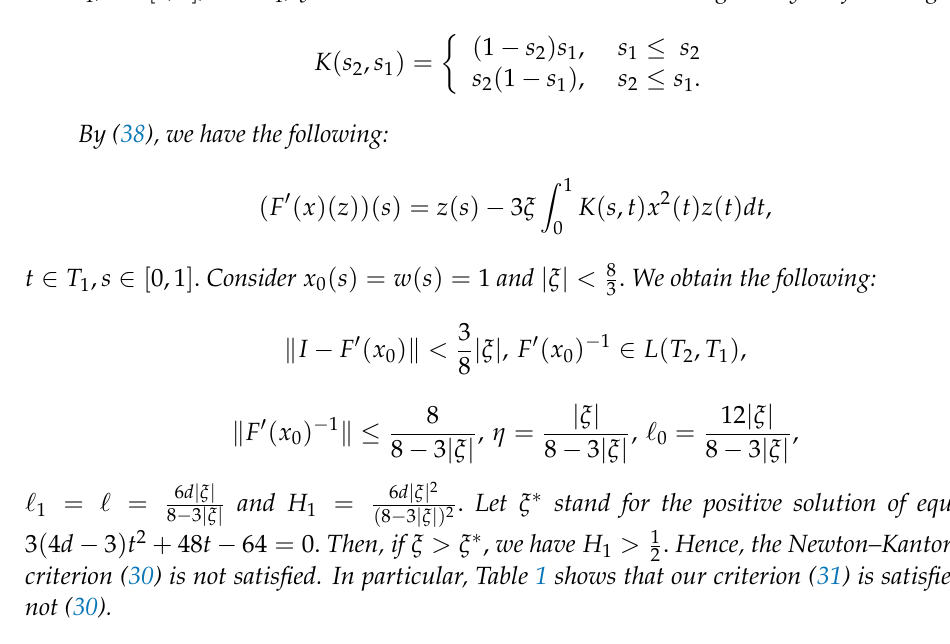
Table 1. Comparison table of criteria (30) and